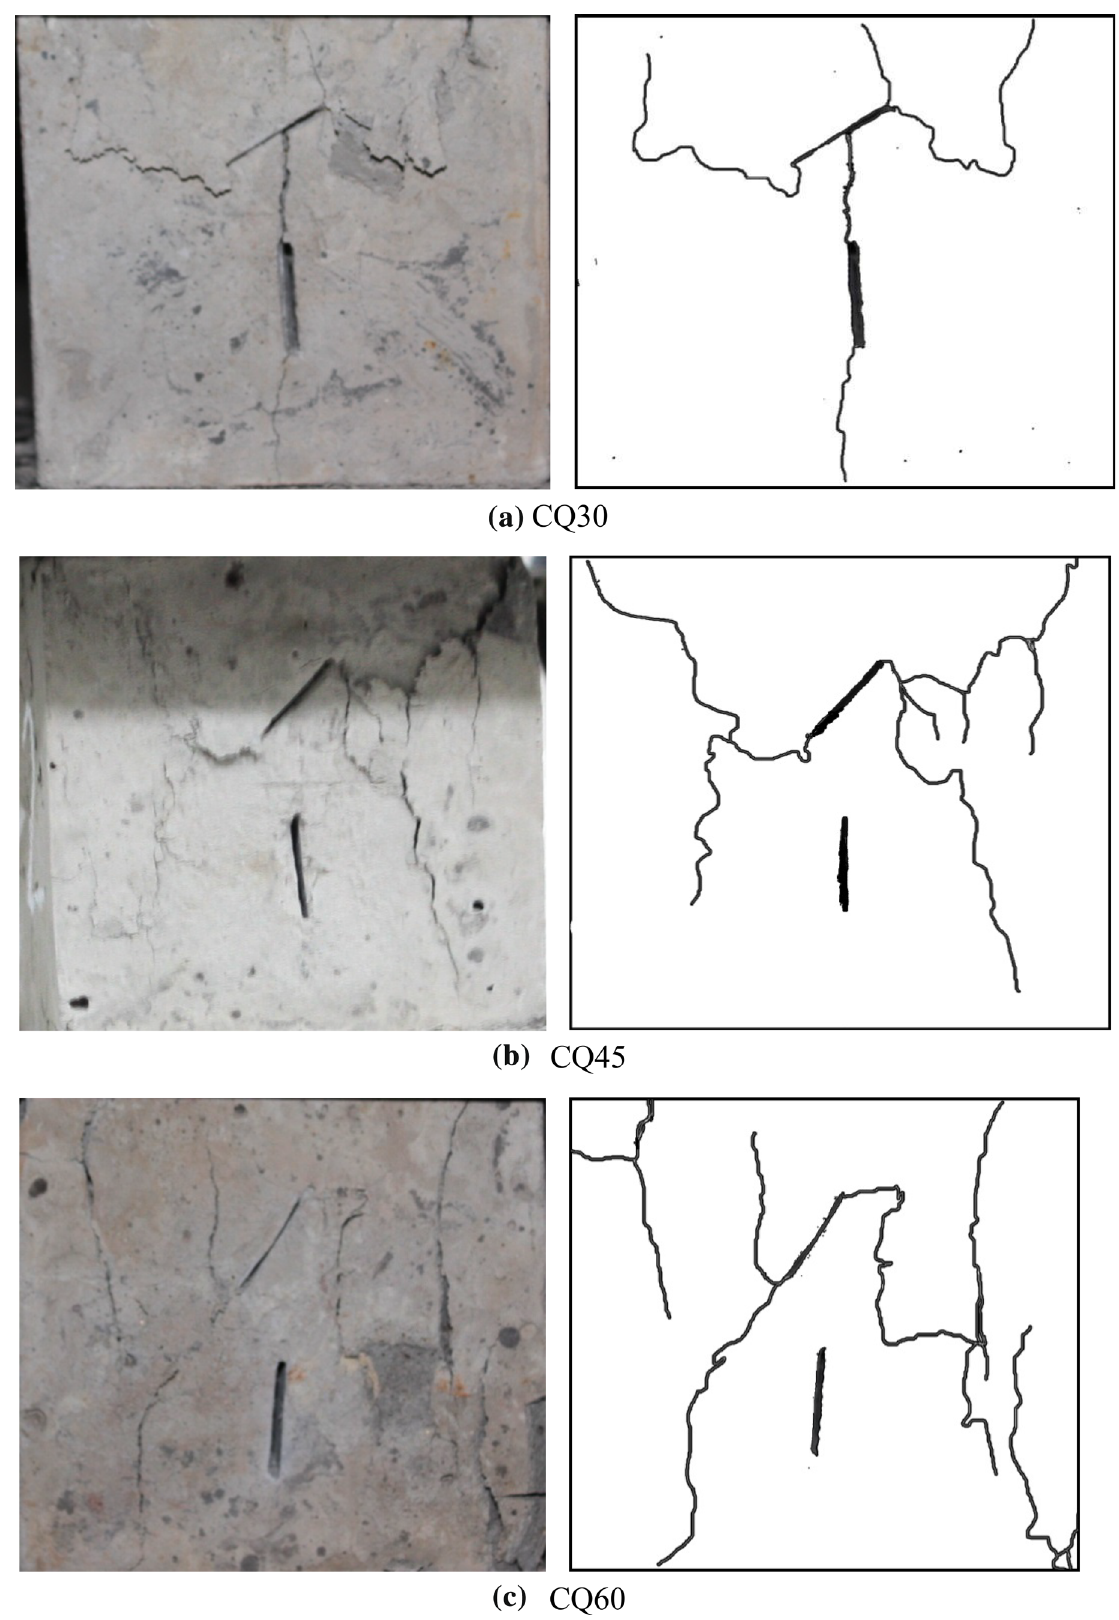
Fig. 6 Failure modes of rock-like specimens with non-parallel double